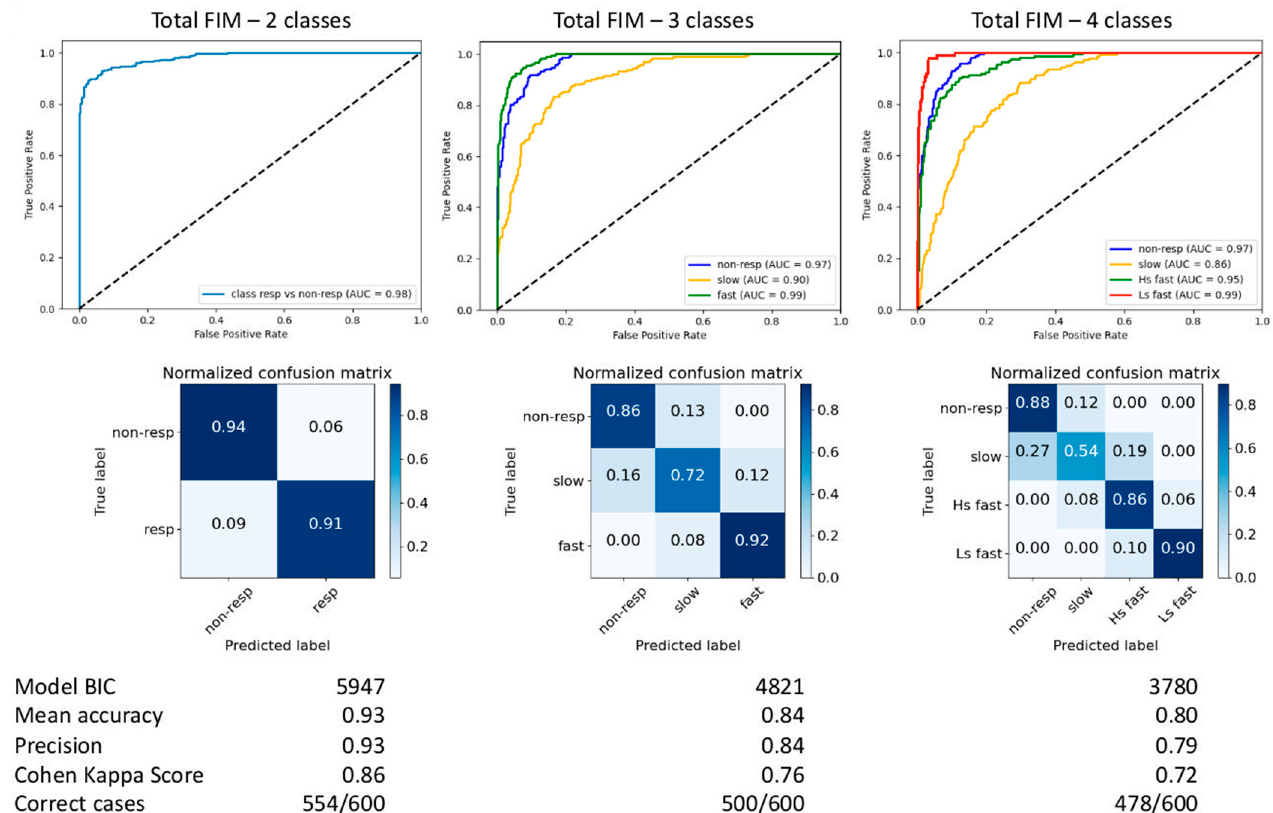
Figure 2. From left to right, prediction performance on previously unseen cases, among two, three and four classes of trajectories. Performance is indicated as per-class area under the curve (AUC in legends), and as overall classification accuracy, precision, Cohen kappa score on the test set, and number of correctly predicted cases. Confusion matrices for two, three and four classes predictions show normalized successful predictions along the main diagonal, and prediction errors off-diagonal. Errors were committed between neighboring trajectories in all cases.